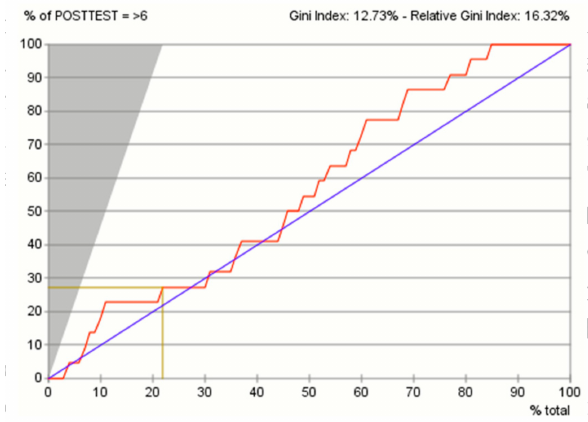
Figure 21. Gains curve.